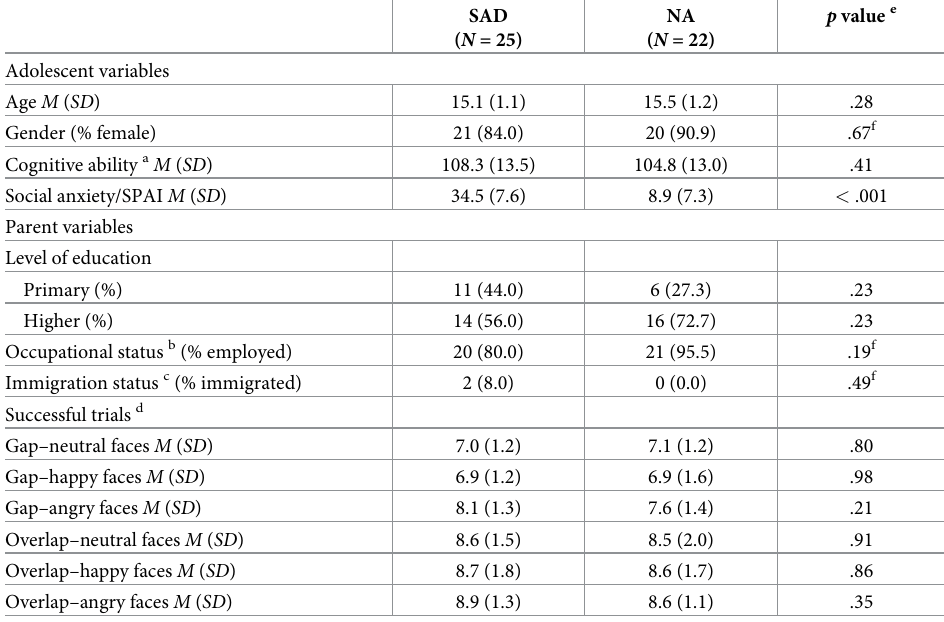
Table 1. Demographics, cognitive ability and number of successful trials in the SAD and NA